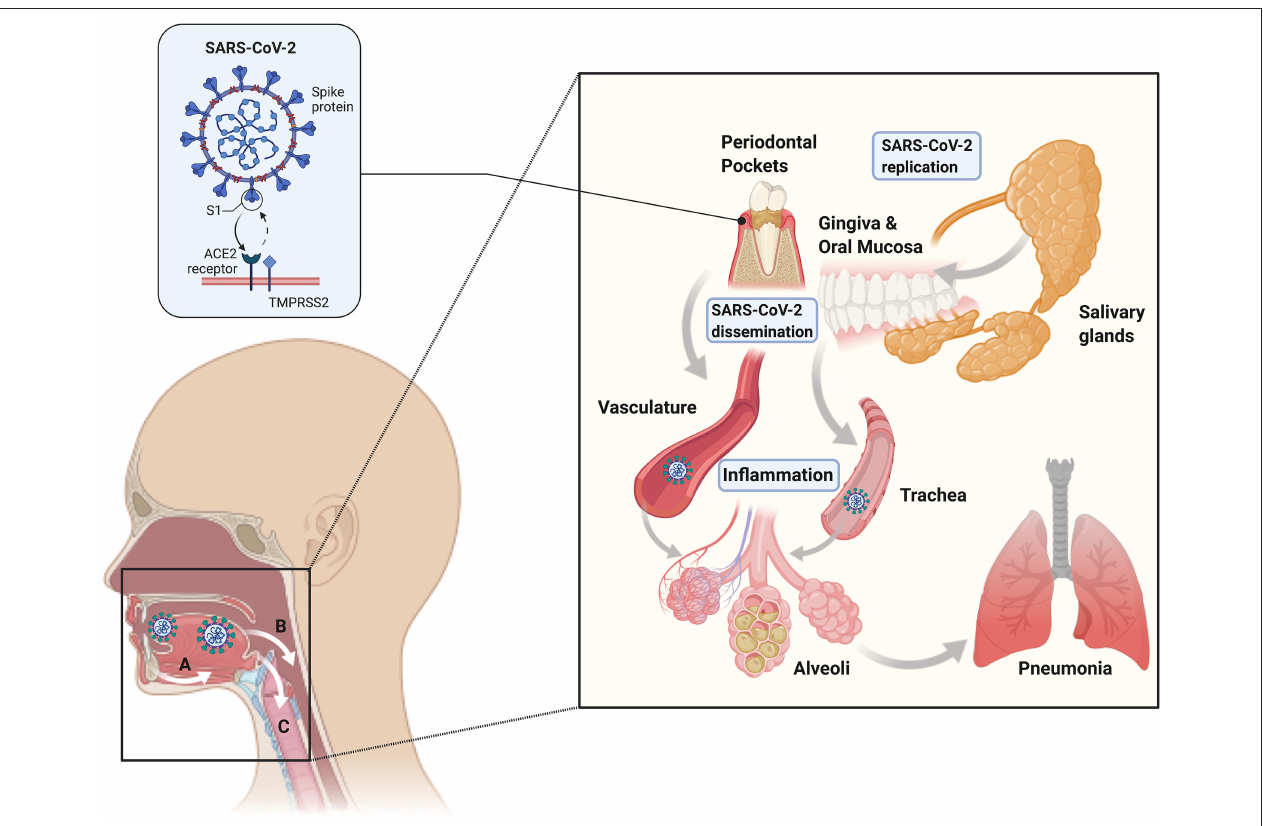
FIGURE 2 | Mechanisms of periodontal-COVID-19 connections. The existing evidence suggests that SARS-CoV-2 can independently replicate in the oral cavity in epithelial cells (including periodontal pockets) and salivary glands ( right inset ). Gingival and mucosal epithelial uptake of SARS-CoV-2 is thought to occur through ACE2-TMPRSS2 receptors ( left inset ). Viral shedding from epithelial surfaces and saliva can lead to systemic dissemination via hematologic (A) , digestive (B) , and respiratory (C) routes. Therefore, the oral cavity can represent a SARS-CoV-2 replication and dissemination reservoir, leading to acute respiratory and lower digestive tract